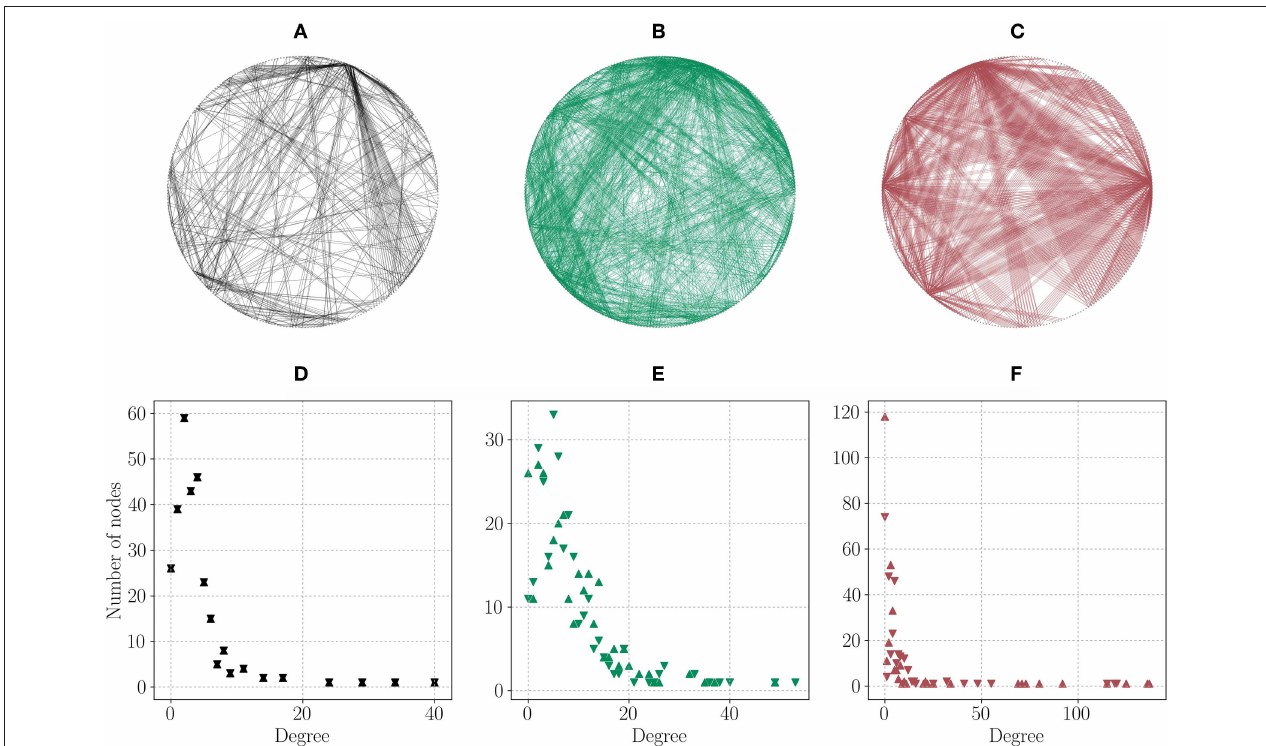
FIGURE 1 | Layers of the C. elegans network and their degree distributions. All networks are plotted undirected and in a ring for visualization purposes only, with the same node positions across layers. ▽ : in-degree, △ : out-degree. (A) Electrical sub-network. (B) Chemical sub-network. (C) Wireless sub-network. (D) Electrical layer degree distribution. (E) Chemical layer in- and out-degree distribution. (F) Wireless layer in- and out-degree